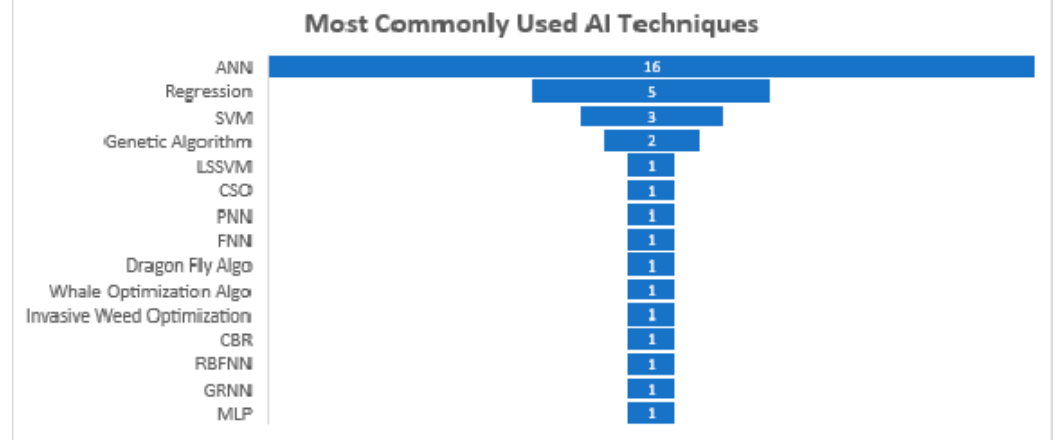
Figure 13. Most commonly used AI techniques in the prediction of soil shear strength and project cost and duration.